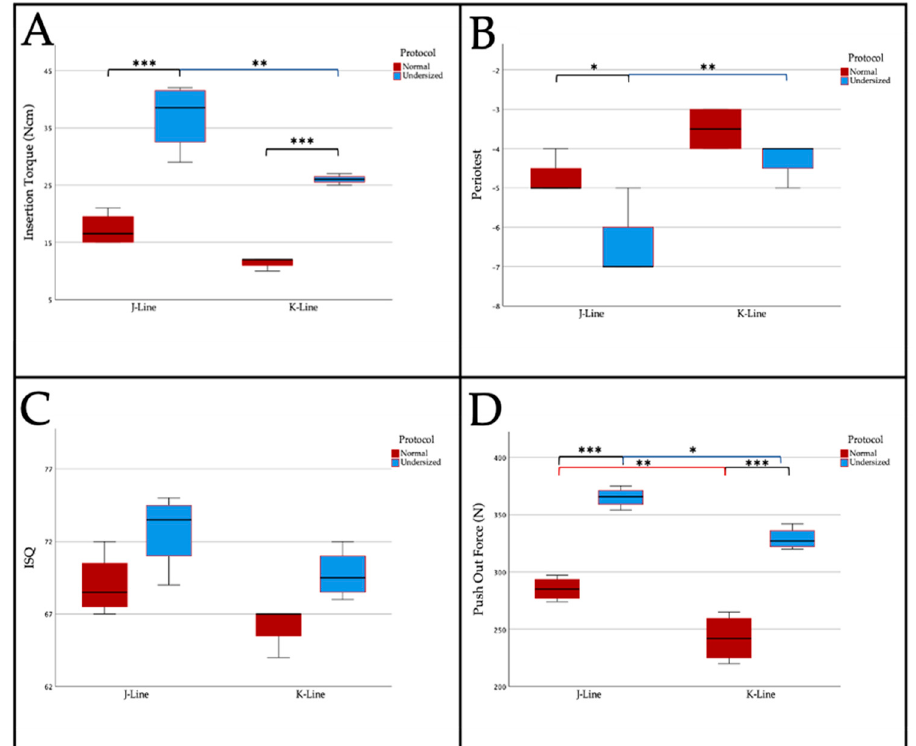
Figure 5. Boxplots illustrating ( A ) insertion torque, ( B ) Periotest ® measurement, ( C ) resonance frequency analysis and ( D ) the push-out forces of the J- and K-line for different drilling protocols in “soft” bone. Within-group significance in assigned colors (J-line blue, K-line pink) and between-group significance is assigned in black. Shown are means ± SD, * p < 0.05, ** p > 0.01 , *** p < 0.001 .